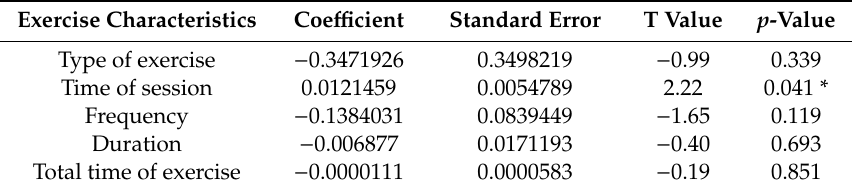
Figure 2. Changes in the quality of life (pooled outcomes) after exercise intervention in patients with breast cancer. SD, standard deviation; IV, inverse variation; CI, confidence internal; df, degrees of freedom. Table 2. Meta-regression analysis to identify the effective exercise moderators on an improved quality of life in breast cancer survivors.